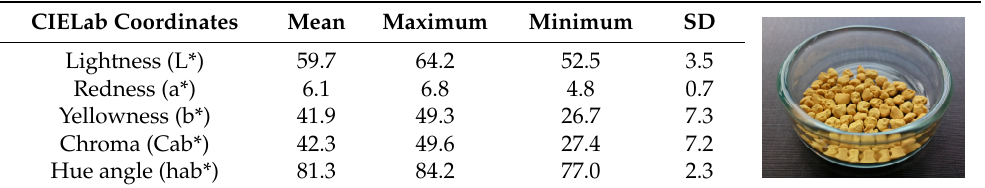
Table 2. Description of the color variables in the CIELab* scale.